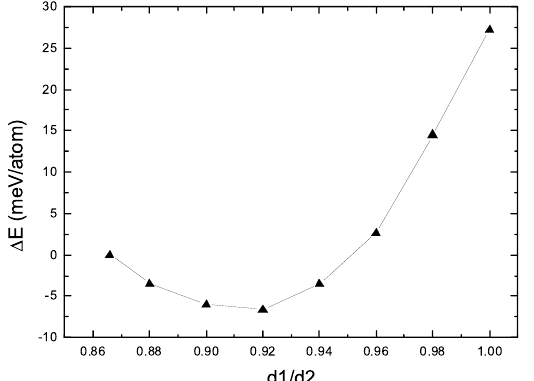
Figure 4. Energy difference ( Δ E) of the unit cell as a function of d1/d2 with respect to the total energy of the unit cell just after the slip and adjustment (d1/d2 = √ 3/2). d1 and d2 are the nearest-neighbor distances in the < > 110 and < > 110 directions,